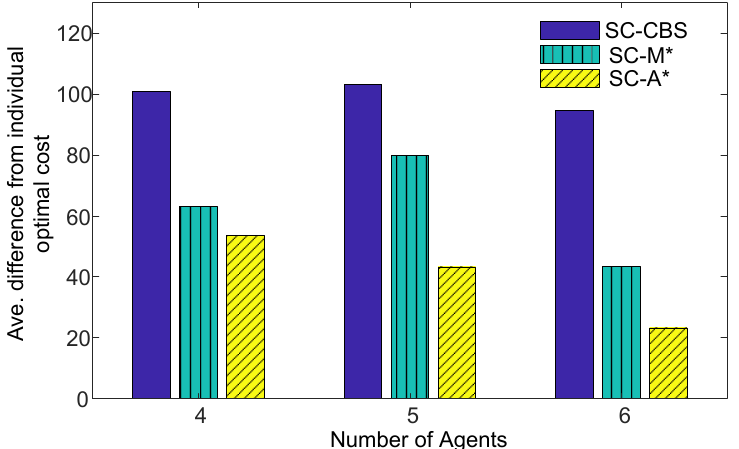
Figure 7. Average cost difference of soft-collision-based multi-agent path planning (SC-based MAPP) solvers from the individually optimal cost in the one-resource-one-type